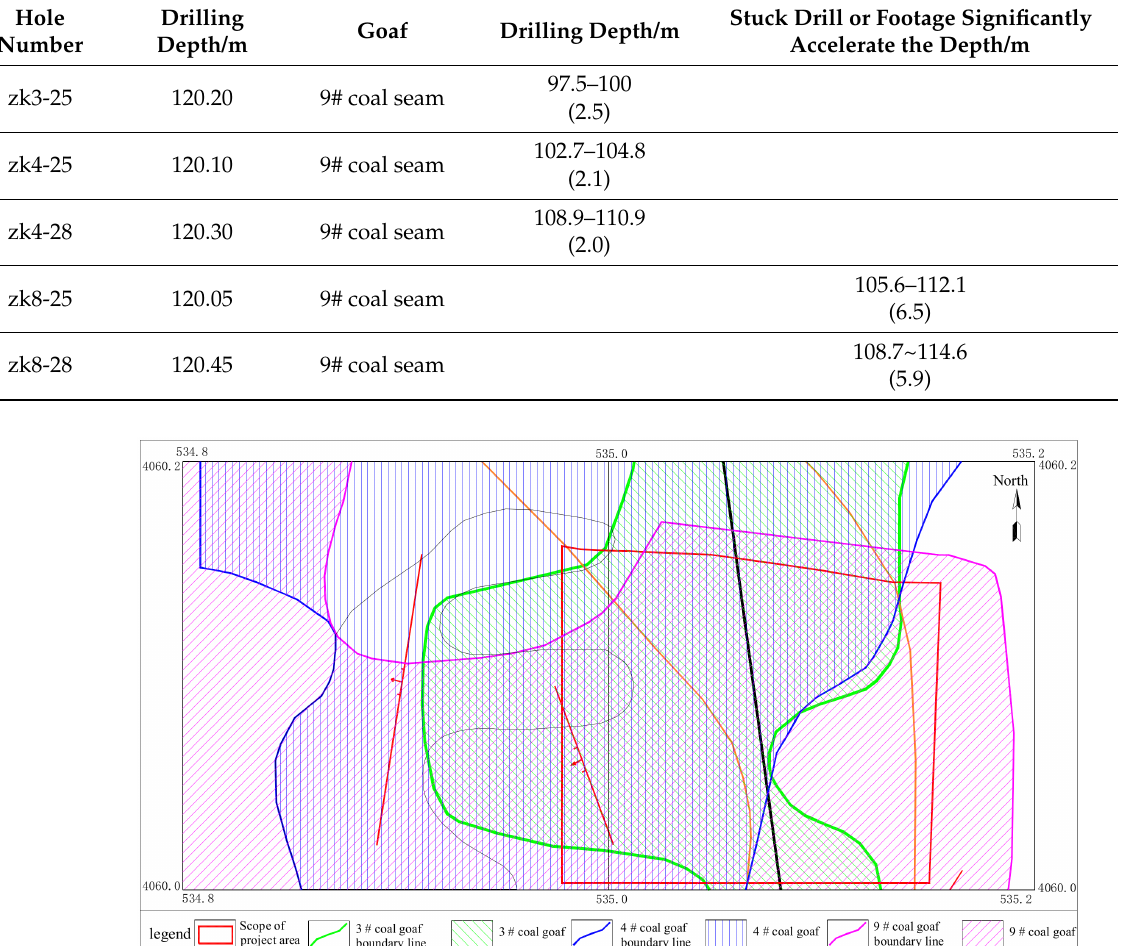
Figure 24. Centralized drilling area of the goaf of the 3#, 4#, and 9# coal seams in the study